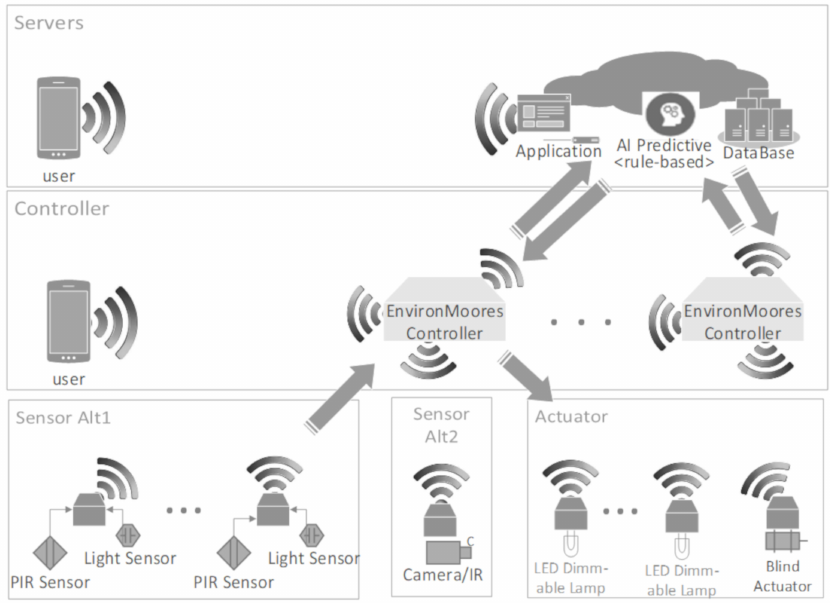
Figure 1. The proposed system